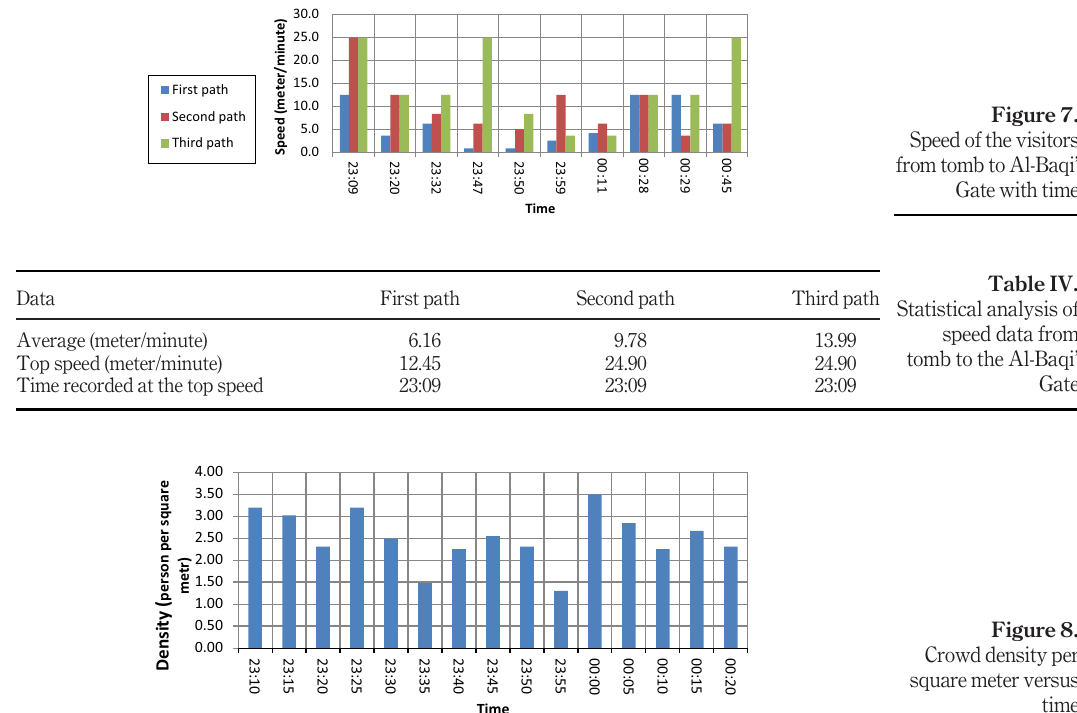
Figure 8. Crowd density per